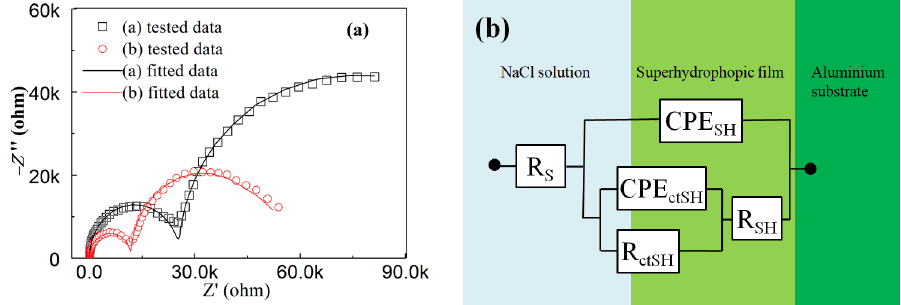
Figure 8. EIS spectra and electrical equivalent circuit of ( a ) stearic-acid-treated sample after Na 2 CO 3 etching after abrasion test and ( b ) stearic-acid-treated sample after NaOH etching at 90 °C after abrasion test.